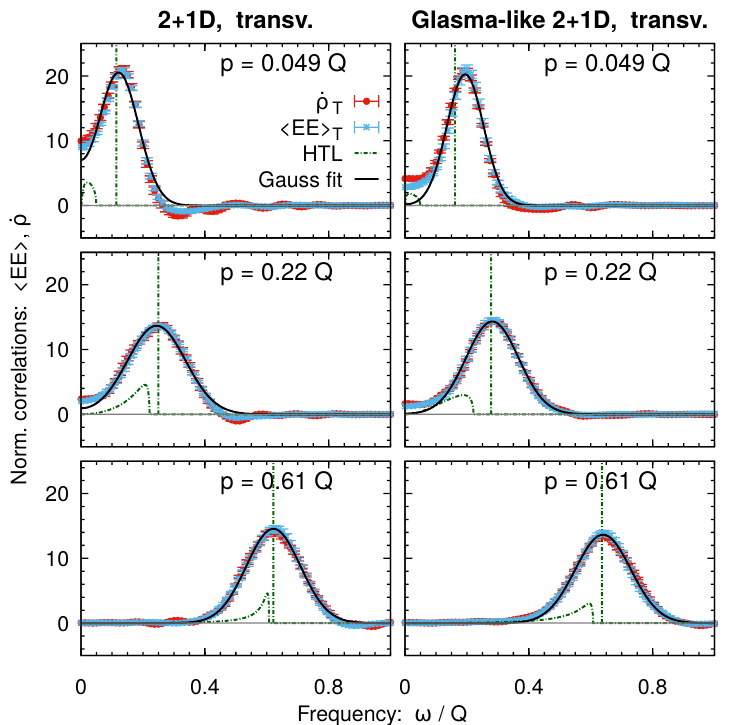
Figure 3 . The transverse normalized statistical correlator h EE i T ( t, ω, p ) / h EE i T ( t, ∆ t =0 , p ) and dotted spectral function ˙ ρ ( t, ω, p ) for both 2 + 1 -dimensional theories at different momenta as T functions of frequency. They lie on top of each other within numerical precision, demonstrating the validity of the generalized fluctuation-dissipation relation (3.1). The HTL expressions for ωρ are shown as green dashed lines while black lines denote fits using the Gaussian distribution in